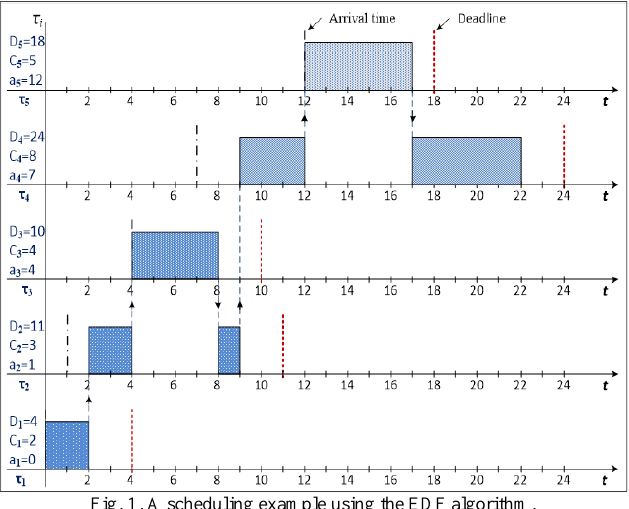
Fig. 1. A scheduling example using the EDF